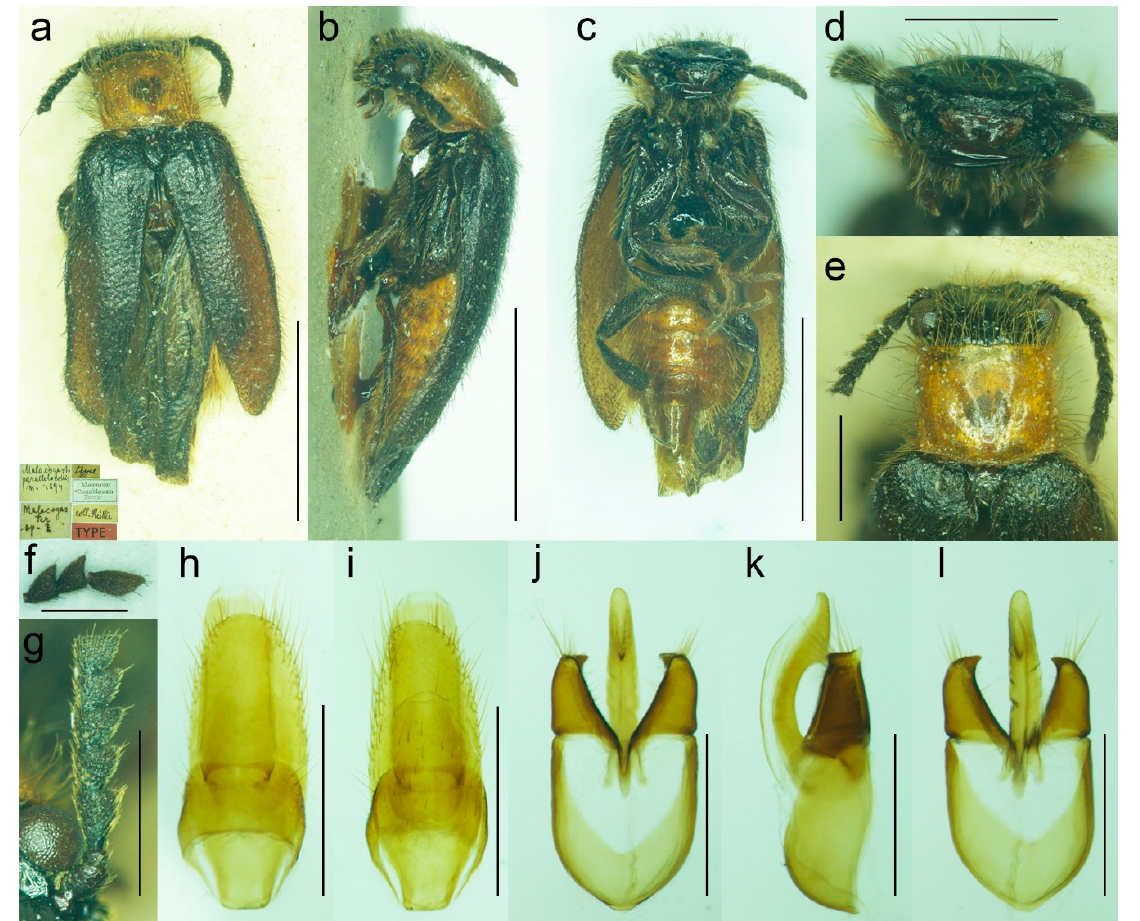
Figure 11. Malacogaster maculiventris Reitter, 1894. Male lectotype of Malacogaster parallelocollis Reitter, 1894, syn. nov. ( a ) Habitus, dorsal view; ( b ) habitus, lateral view; ( c ) habitus, ventral view; ( d ) head, frontal view; ( e ) pronotum, dorsal view; ( f ) apical antennomeres of left antenna; ( g ) basal and median antennomeres of left antenna; ( h ) genital capsule formed by tergites IX and X, and sternite IX, dorsal view; ( i ) genital capsule formed by tergites IX and X, and sternite IX, ventral view; ( j ) aedeagus, dorsal view; ( k ) aedeagus, lateral view; ( l ) aedeagus, ventral view. Scale bars = ( a – c ) 3.0 mm; ( d , e , g – i ) 1.0 mm; ( f , j – l ) 0.5 mm.